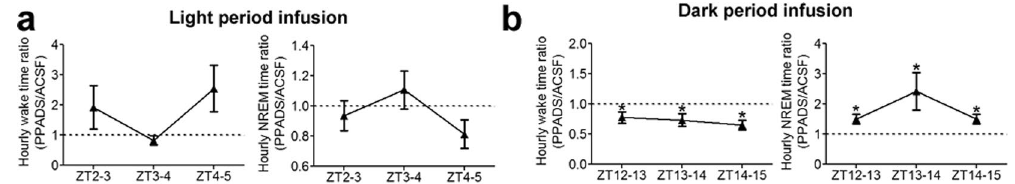
Figure 3. Infusion of the P2XR antagonist, PPADS, into the BF decreased spontaneous wakefulness and increased NREM sleep during the dark (active) period but not during the light period. ( a and b ) Normalized hourly spontaneous wake and NREM during light (ZT2–5. n = 7) or dark (ZT12-ZT15. n = 7) periods with PPADS (300 µ M in infusion solution). Data were normalized to ACSF infusion in the same period. ZT0-ZT12: lights on. ZT12-ZT24/ZT0: lights off. Paired-t-test. * p <